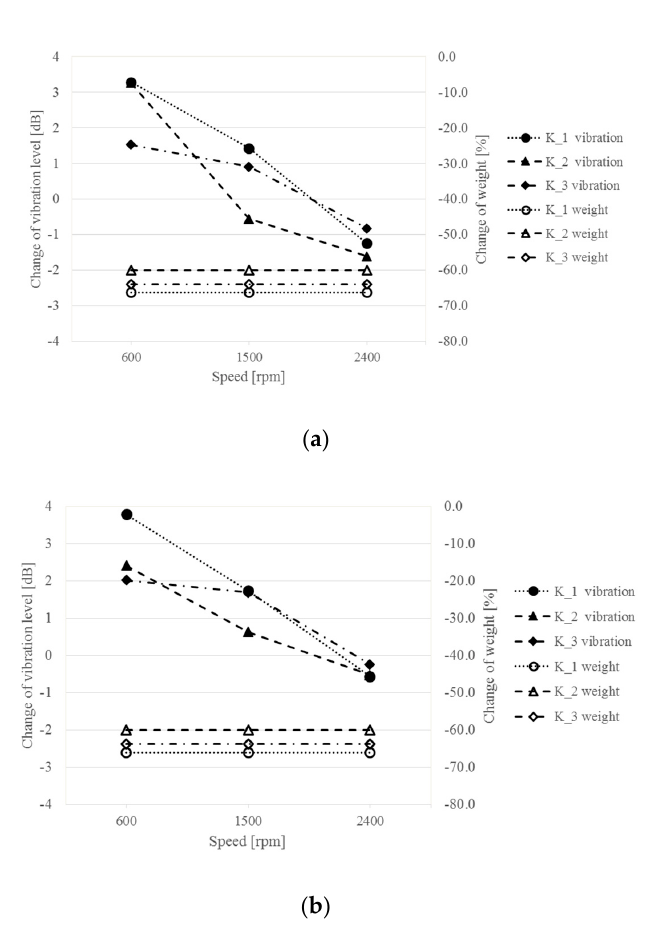
Figure 10. Change in the vibration level in (dB) and weight in (%)—measurement at the load: ( a ) 1.5 MPa; ( b ) 0.75 MPa.